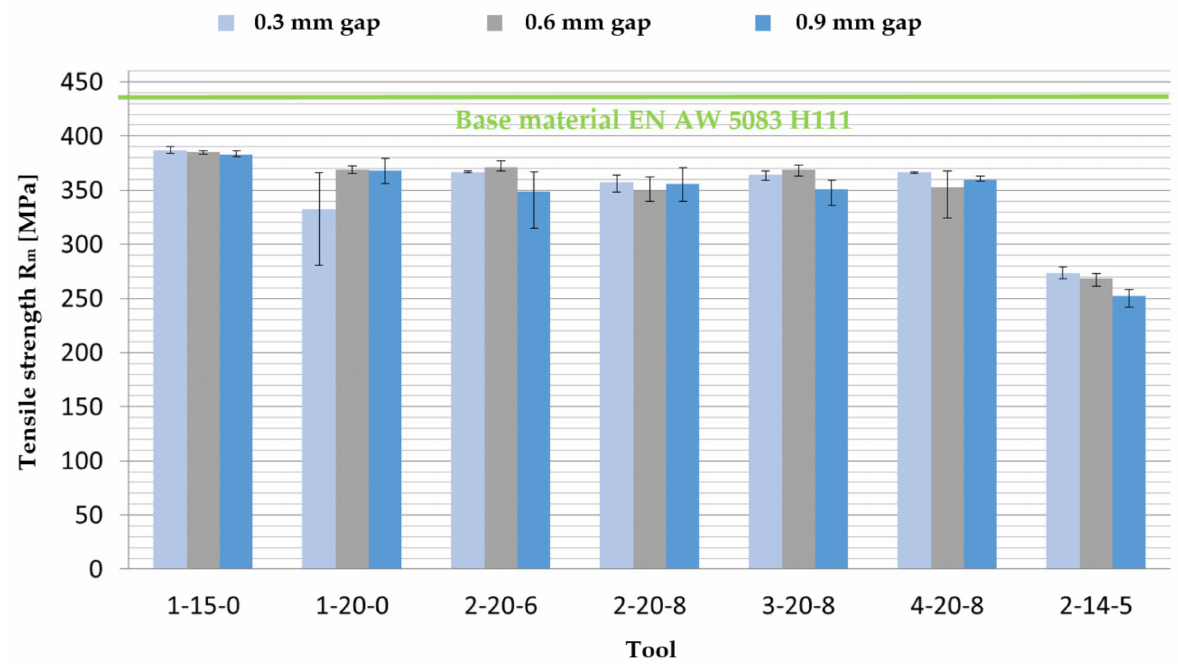
Figure 19. Comparison of tensile strengths of the welded joint on the material EN AW 7020